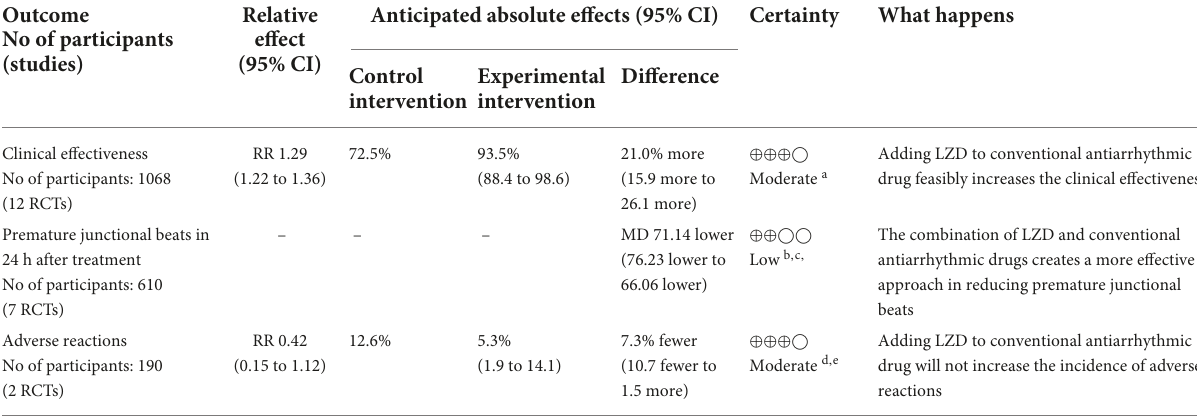
TABLE 4 Summary of findings: LZD for the treatment of premature contraction in patients with coronary heart